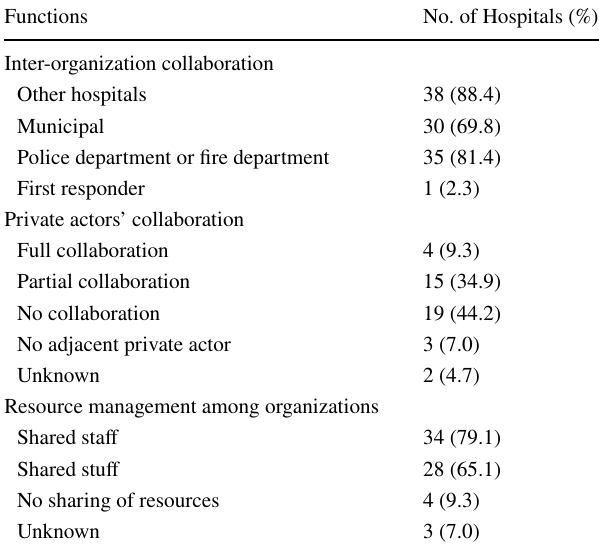
Table 3 Healthcare worker’s knowledge and training in 43 Thai hos- pitals